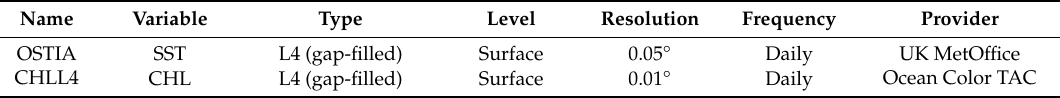
Table 2. Description of the satellite products used in this